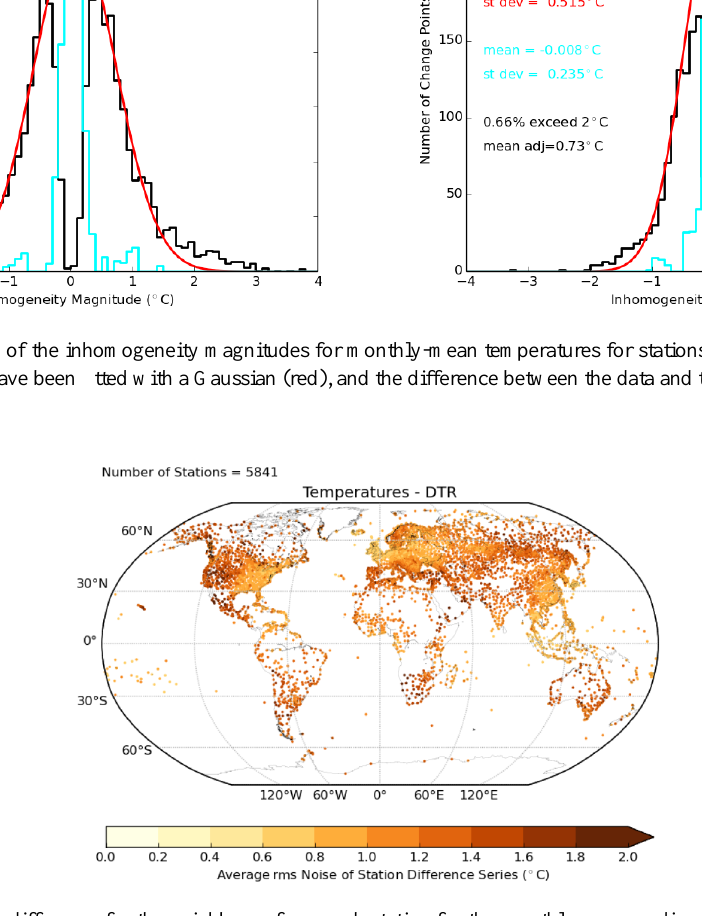
Fig. 19. The average RMS difference for the neighbours from each station for the monthly average diurnal temperature range.